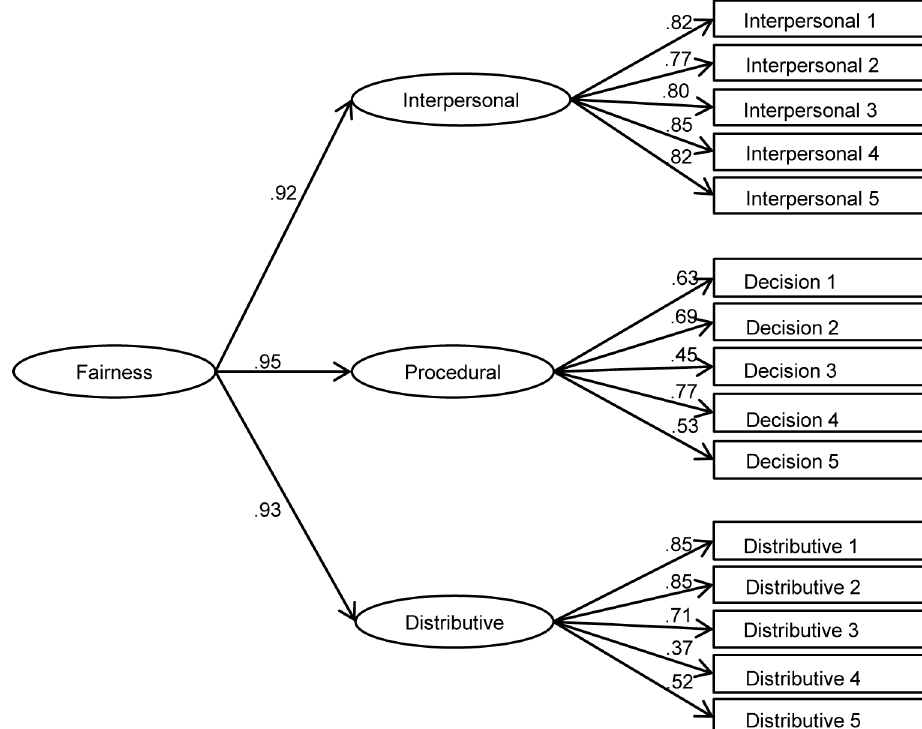
Fig 6. Higher-order factor model in which interpersonal respect, fair decisions and distributive fairness indicate a superordinate fairness factor (model E).